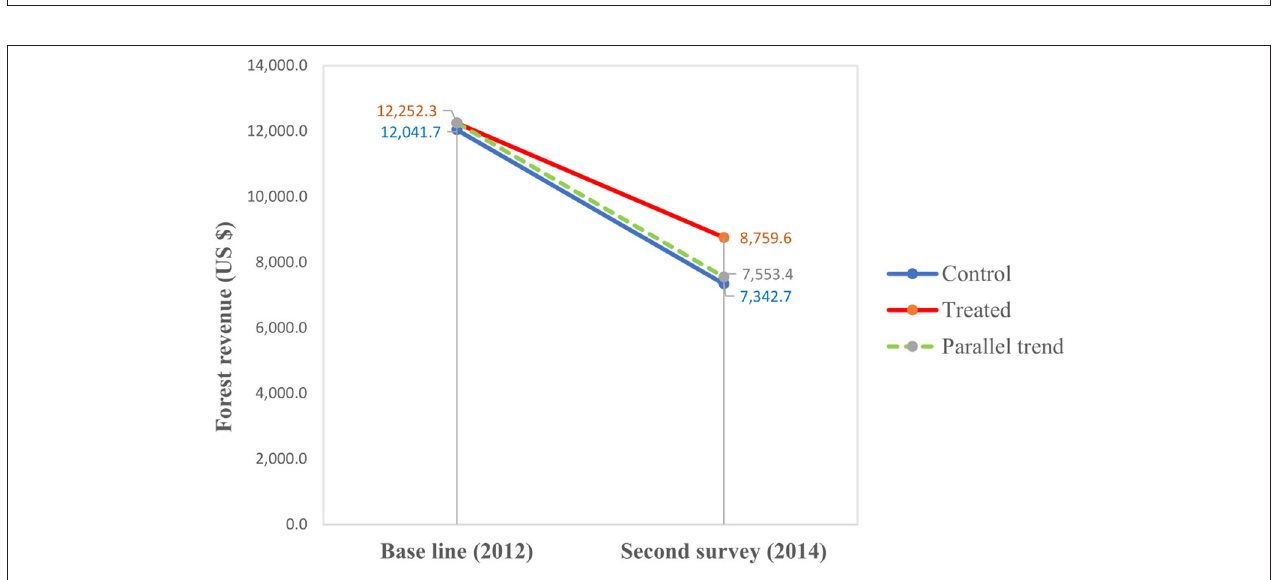
FIGURE 5 | Change in annual forest revenue Ucayali site.